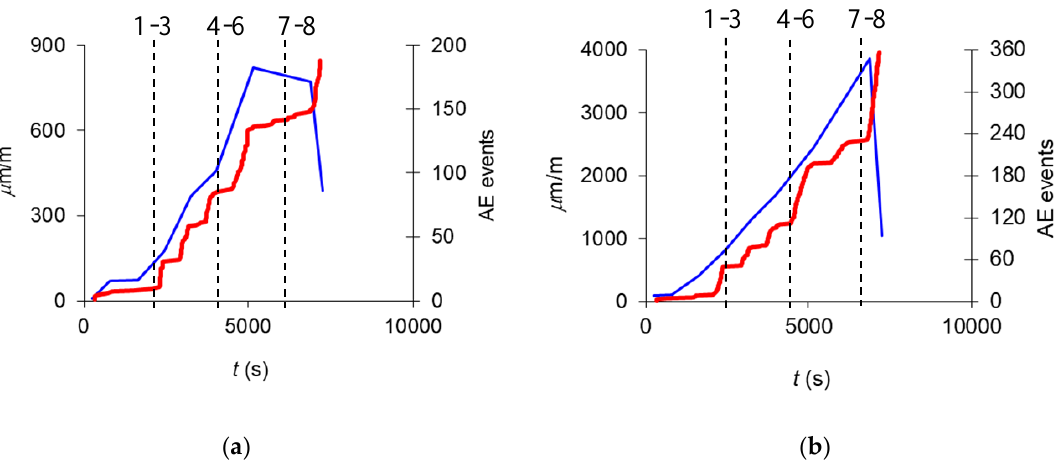
Figure 12. Cumulative AE activity (red) and FOS strain (blue) time histories for: ( a ) fiber optic n.9 at x = − 1.6 m and AE sensor n.4; ( b ) fiber optic n.9 at x = − 1.2 m and AE sensor n.5. The dashed lines identify the different loading stages.